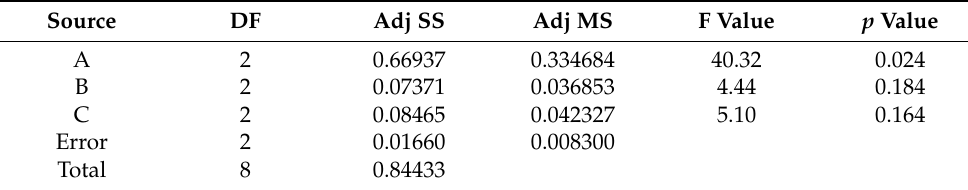
Table 6. ANOVA for Ci* values by TOPSIS method.